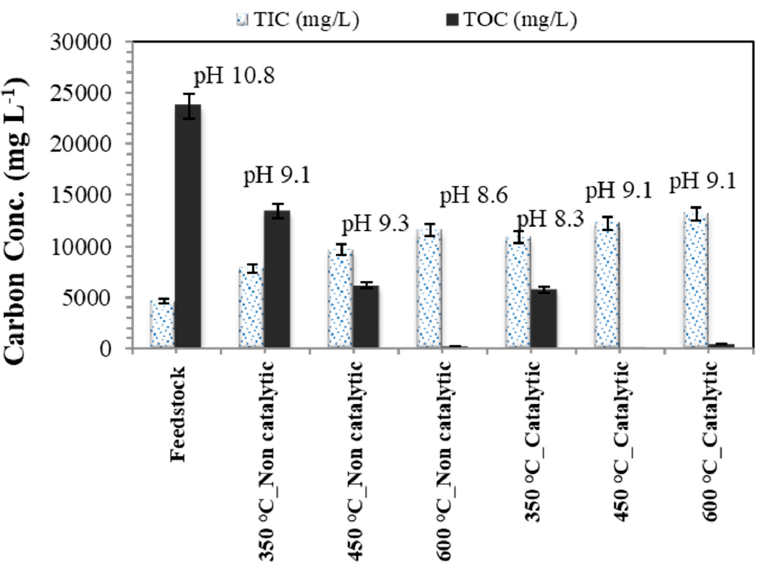
Figure 6. Organic and inorganic carbon contained in the feedstock and in the remaining aqueous phase (after SCWG process). phase (after SCWG process).